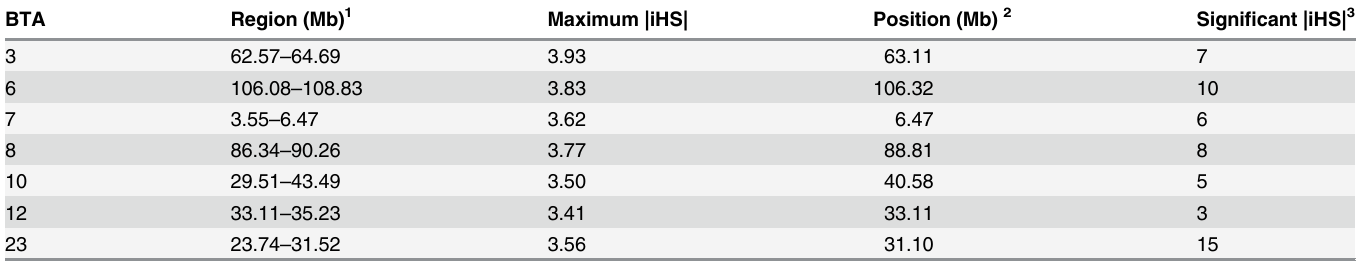
Table 3. Genomic regions encompassing significant |iHS| scores.